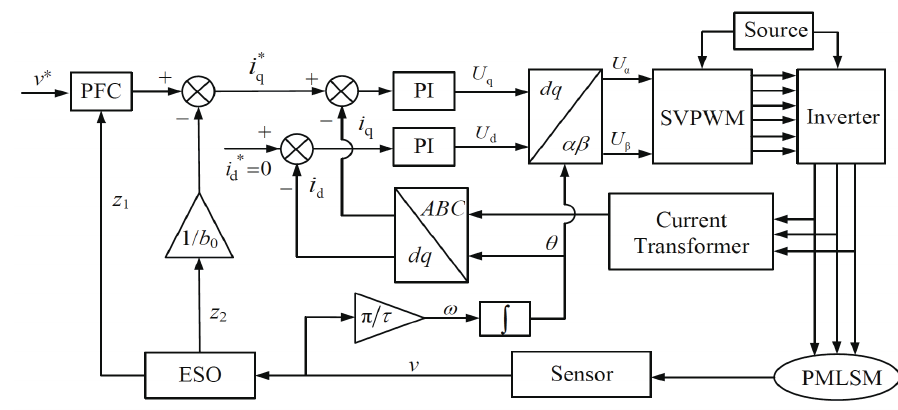
Figure 2. The ESO-based PFC control for the PMLSM.